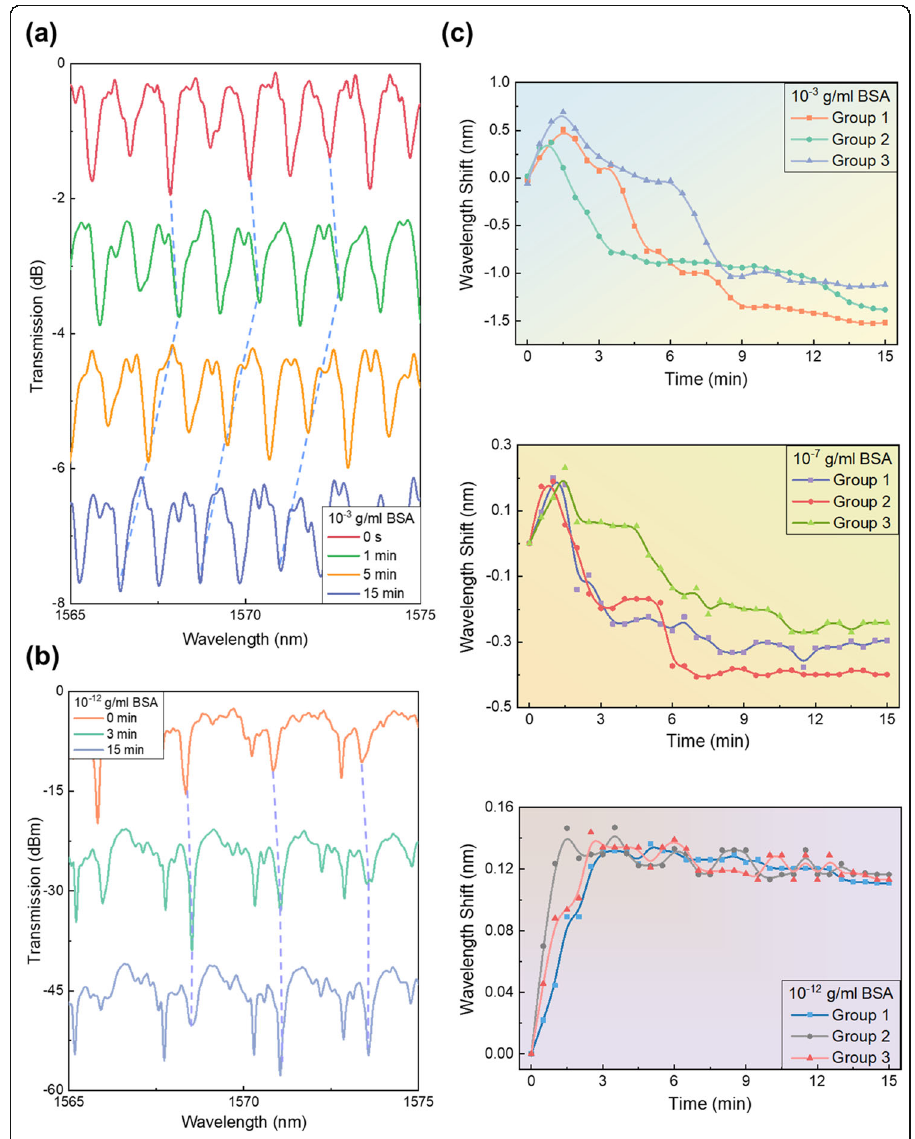
Fig. 3 WGM laser spectra of the LC-amplified optofluidic resonator under ( a ) 10 − 3 g/ml BSA (at 0, 1, 5, 15 mins, respectively) and ( b ) 10 − 12 g/ml BSA (at 0 and 15 mins). ( c ) Real-time monitoring of WGM laser spectral shift of the LC-amplified optofluidic resonator under different BSA concentrations (10 − 3 , 10 − 7 , 10 − 12 g/ml BSA, from top to bottom) within 15 mins. (Points in the same group are connected by B-spline